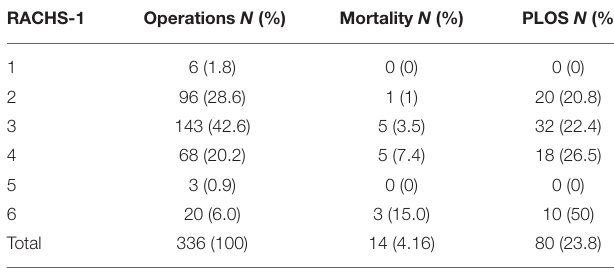
TABLE 3 | Distribution of cases operated abroad by complexity level, mortality, and PLOS, expressed in RACHS category classification (2003–2007).